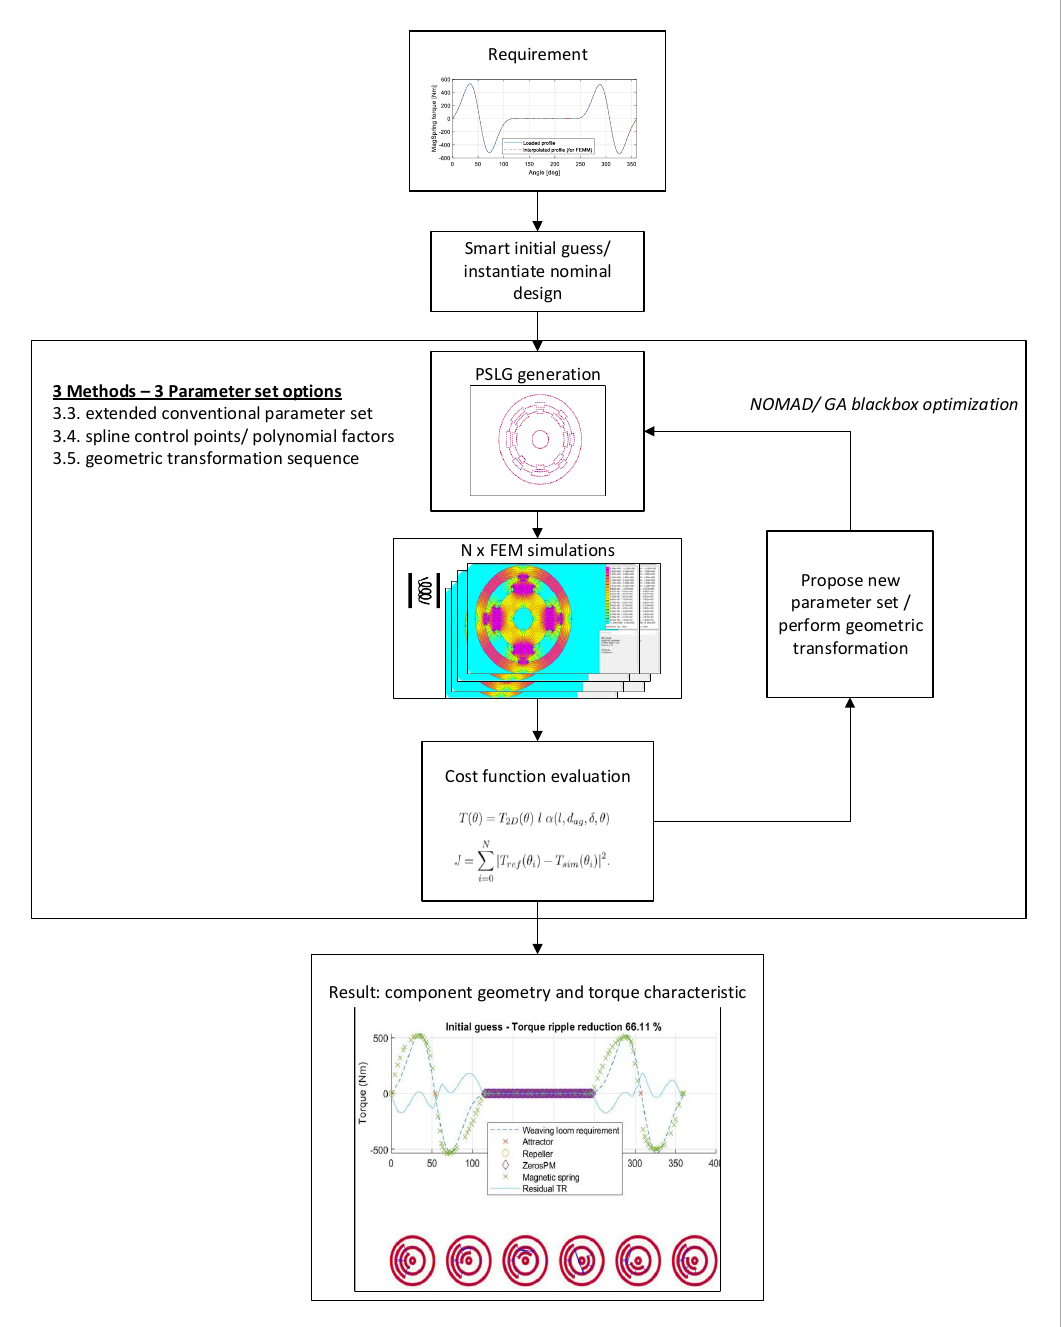
Figure 4. Overview of unified shape optimization